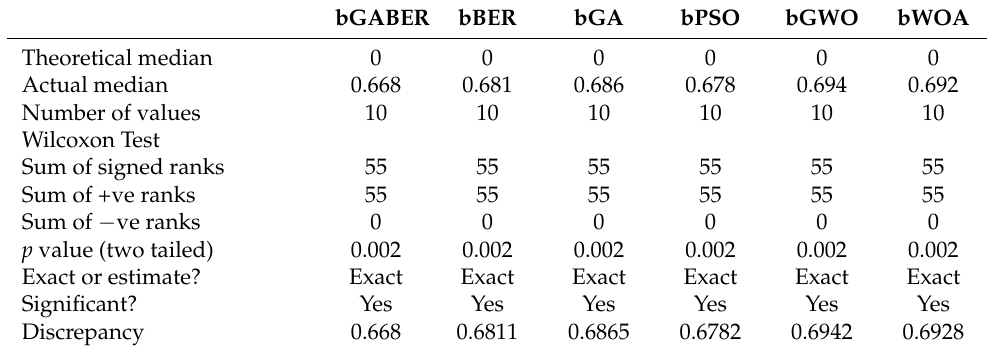
Table 7. Wilcoxon of the proposed feature selection method based on the wind speed